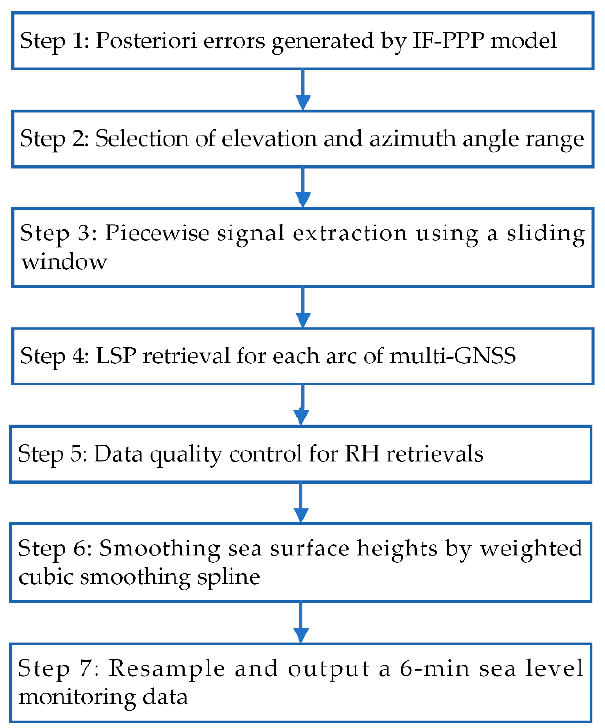
Figure 8. Flow chart of a high-temporal GNSS-IR sea-level retrieval method.